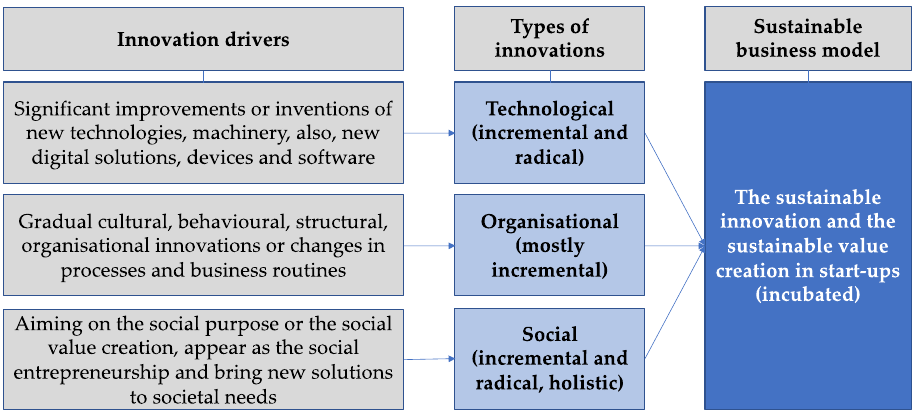
Figure 1. Drivers and types of innovations for the creation of sustainable value in start-ups (source: the authors).